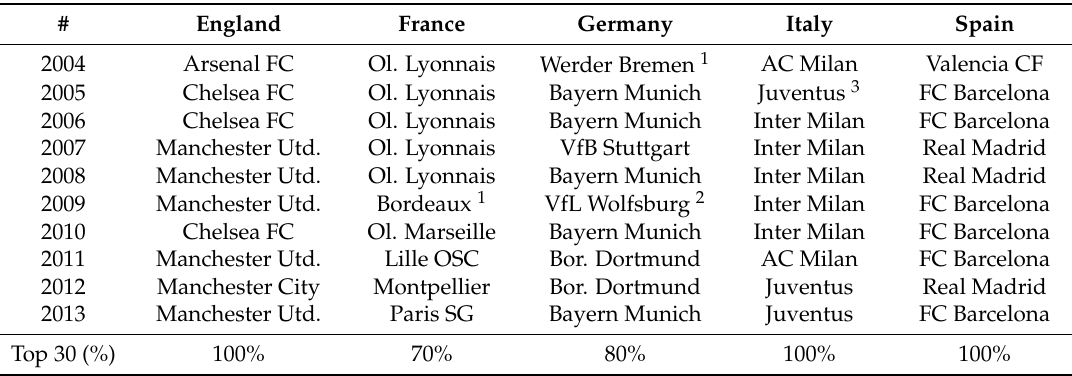
Table 2. National league titles in “Big Five” leagues (2004–2013).